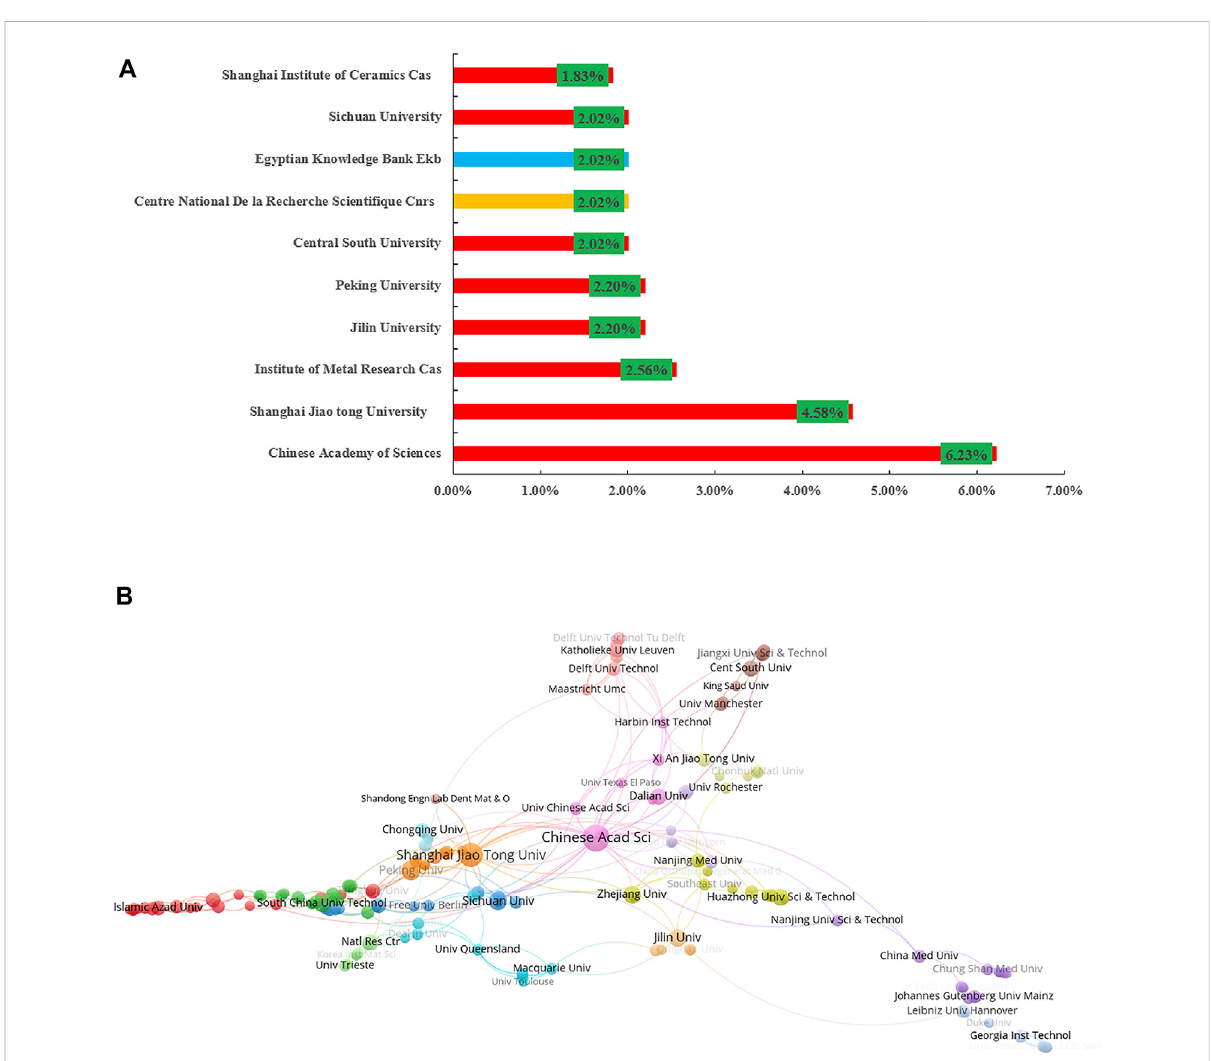
FIGURE 6 Distribution of journals engaged in research on metal materials and bone repair. ( A ) Top 10 journals by number of publications. Numbers represent the percentage of publications, and different colors represent different countries (B) network of journals visualized in VOSviewer. The size of the circles represents the number of